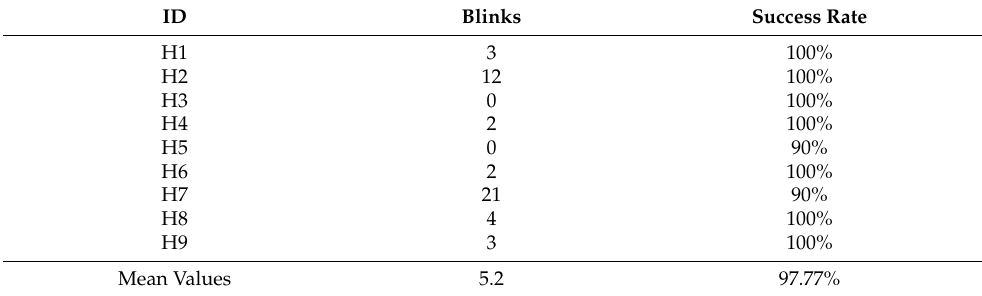
Table 6. Memory-guided saccade test: success rate in memory saccade for healthy control